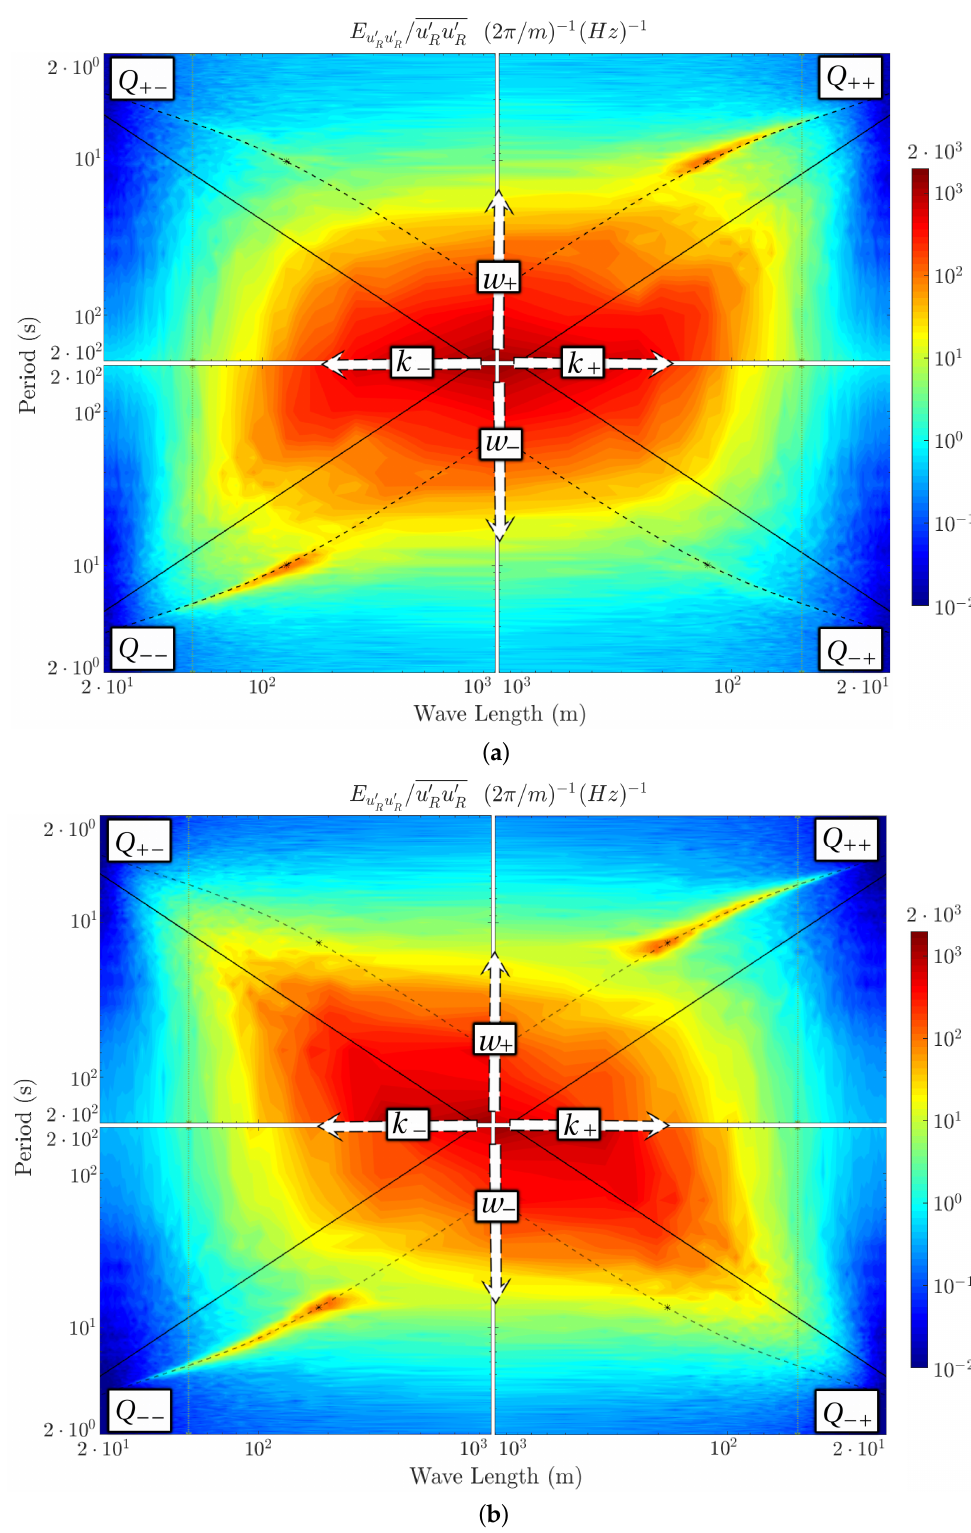
u (cid:48) , referred to by negative R R